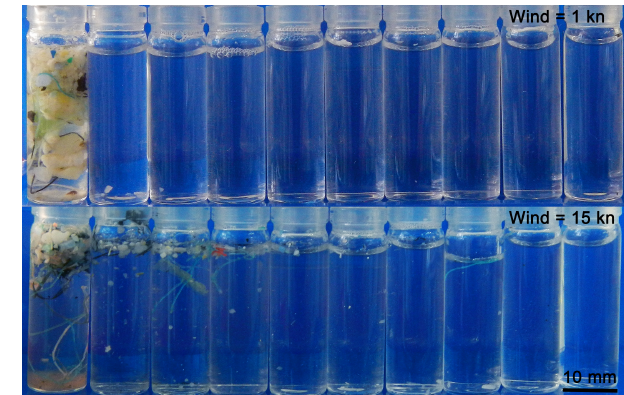
Figure 4. Glass jars with filtered water and plastic samples collected under wind speeds of 1kn (Beaufort number 1, top image) and 15kn (Beaufort number 4, bottom image). From left to right: 0–0.5, 0.5–1, 1–1.5, 1.5–2, 2–2.5, 2.5–3, 3–3.5, 3.5–4, 4–4.5, and 4.5–5m depth